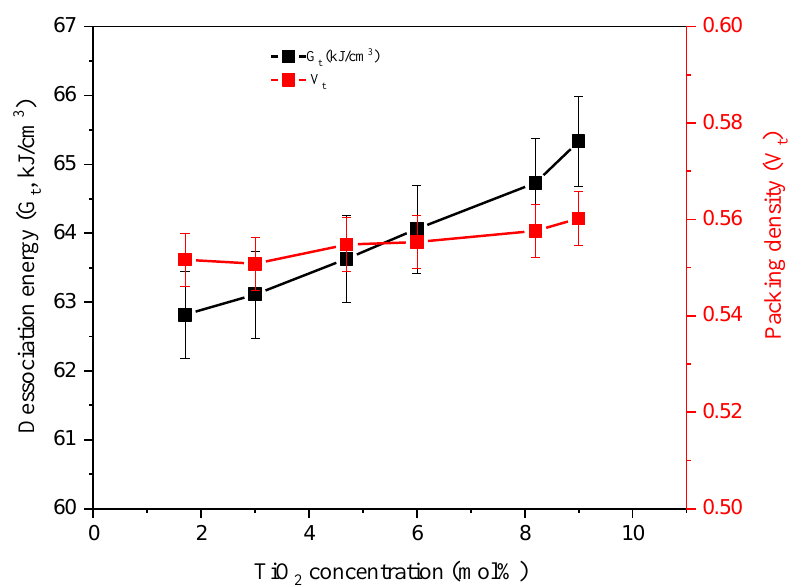
Figure 3. Variation of the dissociation energy (G t ) and the packing density (V t ) versus TiO 2 concen- tration.